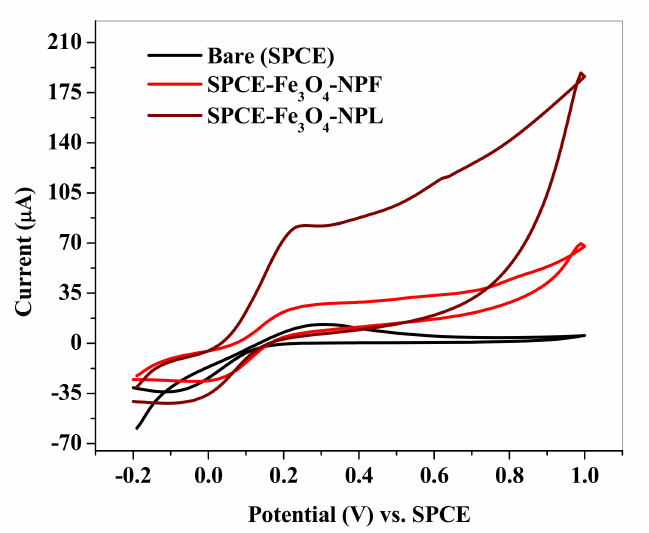
Figure 11. Cyclic voltammogram of bare SPCE, SPCE-Fe 3 O 4 -NPF, and SPCE-Fe 3 O 4 -NPL at 25 mVs −